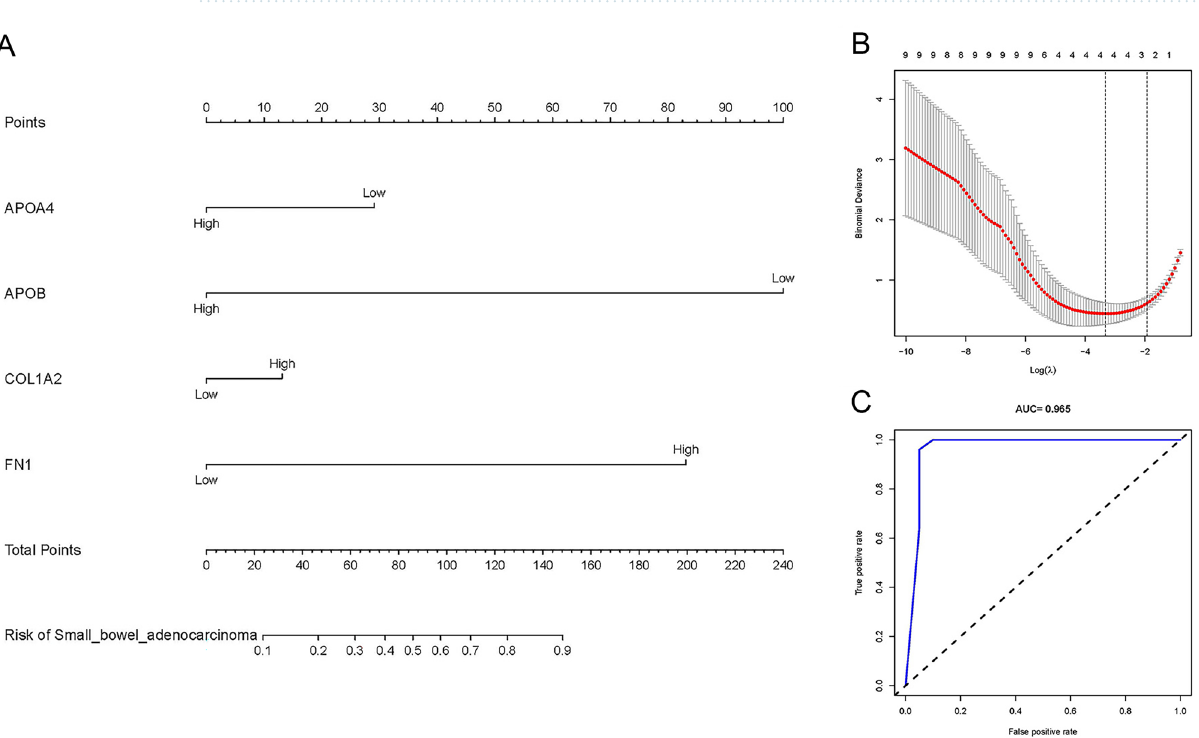
Figure 3. SBA risk prediction model based on 4 target genes. ( A ) SBA risk prediction model based on four target genes. ( B ) Optimal parameter (lambda) selection in the LASSO model used fivefold cross-validation via minimum criteria. The partial likelihood deviance (binomial deviance) curve was plotted versus log(lambda). Dotted vertical lines were drawn at the optimal values by using the minimum criteria and the 1 SE of the minimum criteria (the 1-SE criteria). ( C ) ROC Curves. SBA small bowel adenocarcinoma, LASSO least absolute shrinkage and selection operator, SE standard error, ROC receiver operating